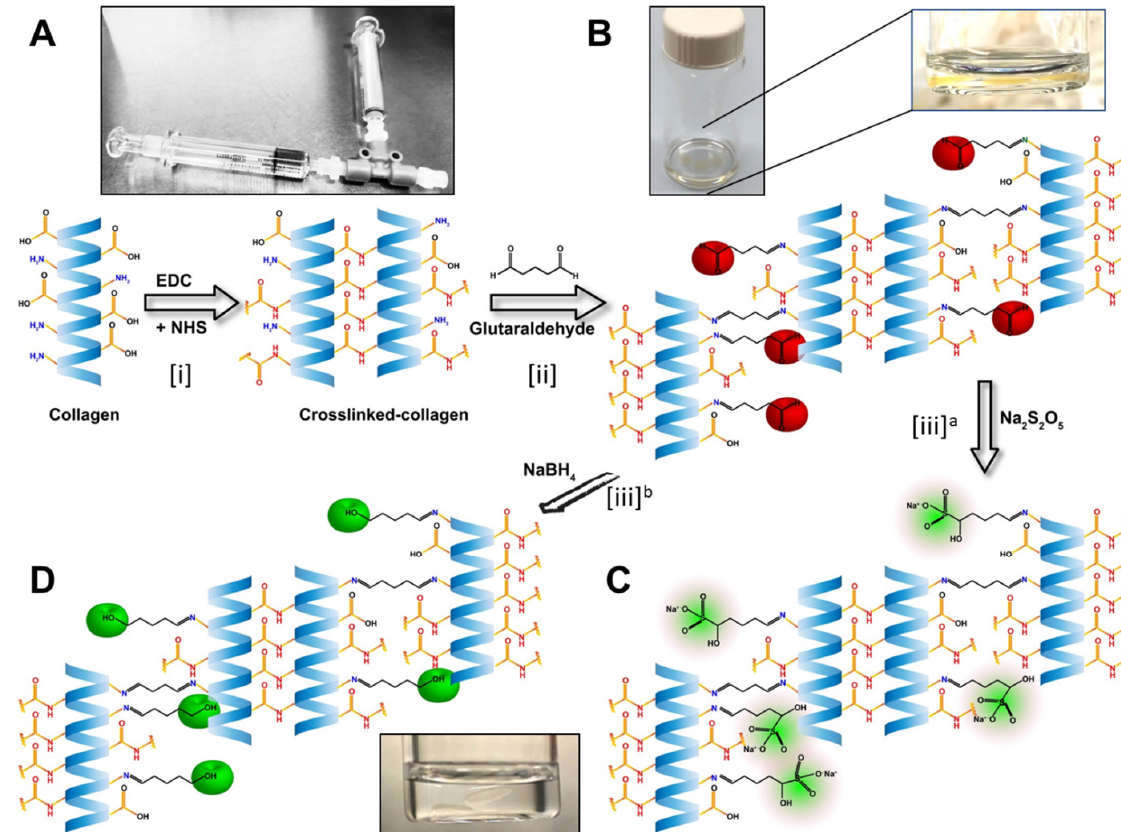
Figure 1. Stepwise illustration of the chemical reactions in the development of the biomaterials. ( A ) Illustration of the EDC/NHS crosslinking of the collagen. The T-piece syringe mixing system was used for making the hydrogels. ( B ) Hydrogels from the previous step crosslinked with GTA, leaving the unreacted aldehyde groups marked as red. Magnified image of a hydrogel in the GTA solution. ( C ) Neutralization of the free aldehyde groups with Sodium metabisulfite (Na 2 S 2 O 5 ; in green). Alternatively, ( D ) neutralization of the free aldehyde groups by Sodium borohydride (NaBH 4 ) and conversion of aldehyde group to alcohol groups (green).